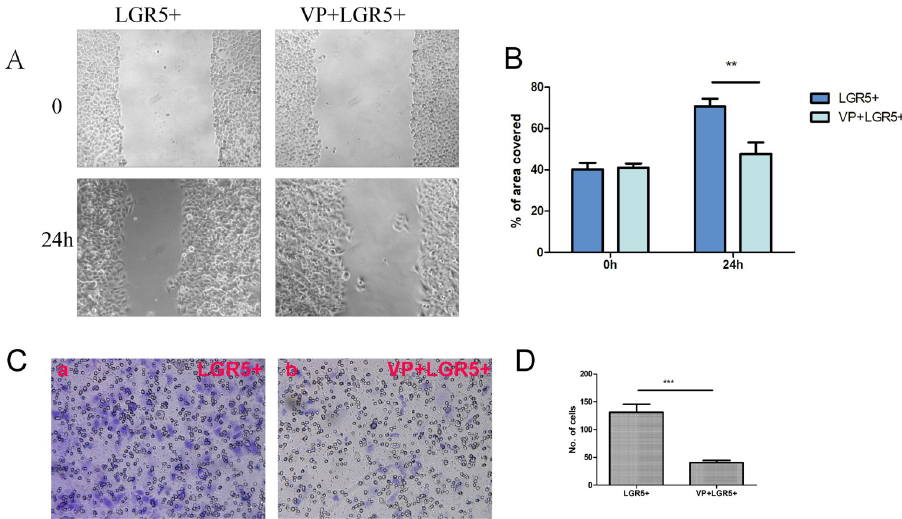
Fig 6. VP affects the invasion and migration of FaDu cells. A-B: The ability of cell migration was measured by the wound healing test. Quantification (B) and representative imaging (A) are shown. Scale bar = 50 μ m. C-D. The invasiveness of FaDu cells was detected by the transwell assay. The pore diameter of the chamber is 8 μ m. Quantification (D) and representative imaging (C) are shown. After 24 hours, each experimental group was compared in terms of the percentage of wound healing distance between cell scratches or the number of migrating cells. Scale bar = 20 μ m. The mean between the groups was compared by independent samples t-test. Statistical significance is denoted by �� P < 0.01, ��� P <